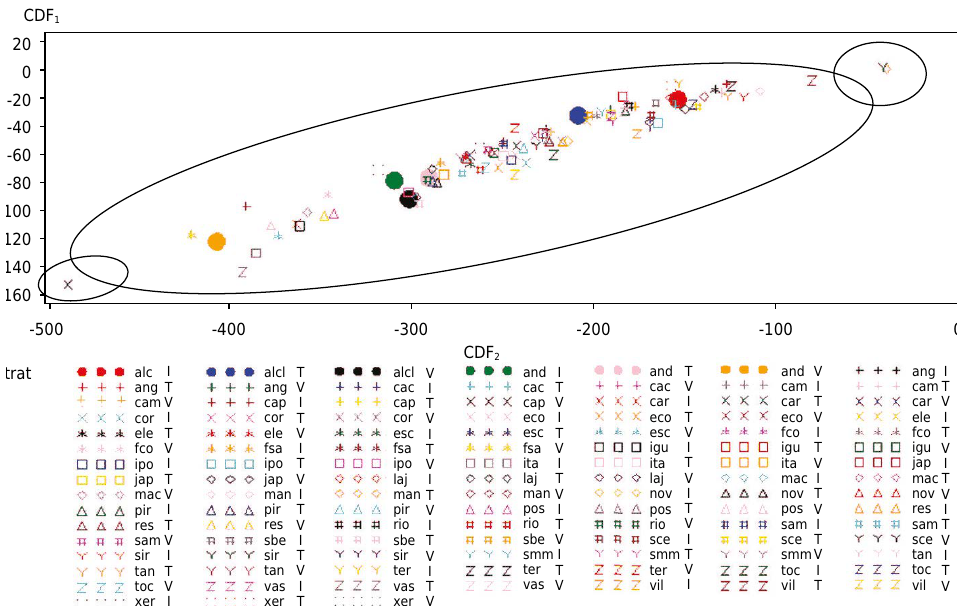
Figure 3. Standardized scores of the significant canonical discriminant functions (CDF) of rainfall and erosivity attributes for the 36 localities of the state of Rio de Janeiro,